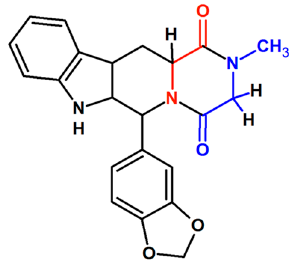
Figure 15. Schematic presentation of tadalafil. N -methylglycine moiety with α -C hydrogen atom marked in blue, N -substituted glycine moiety marked in red.